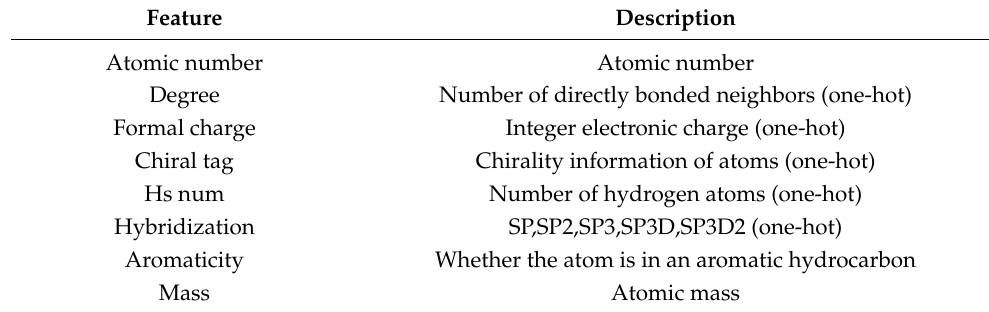
Table 1. Atomic Features.